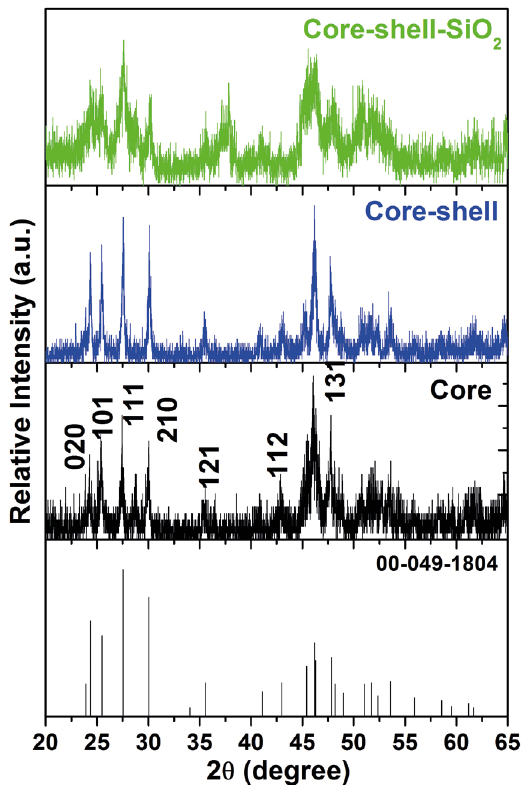
Figure 1. X-ray diffraction pattern of core, core-shell and core- shell-SiO 2